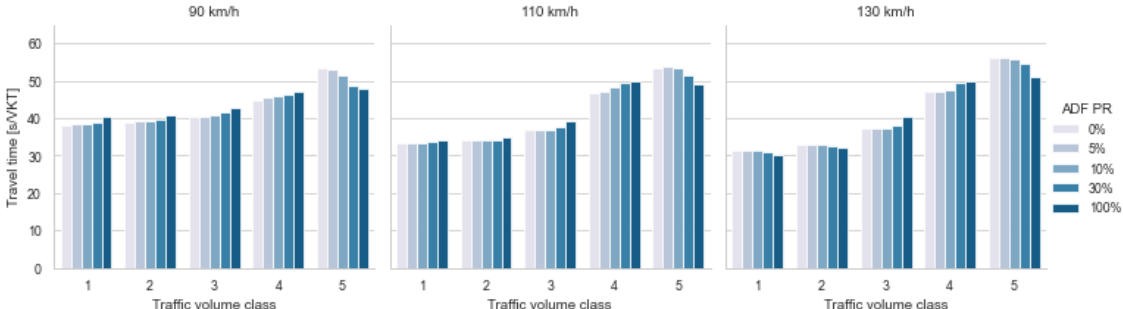
Figure 3. Average travel time in seconds per VKT for speed limits of 90, 110 and 130 km/h per traffic volume class and AV penetration rate among passenger cars on EU27+3 motorways. Volume class 1: up to 750 veh/h/lane; 2: 751–1250 veh/h/lane; 3: 1251–1750 veh/h/lane; 4: 1751–2250 veh/h/lane; 5: over 2250